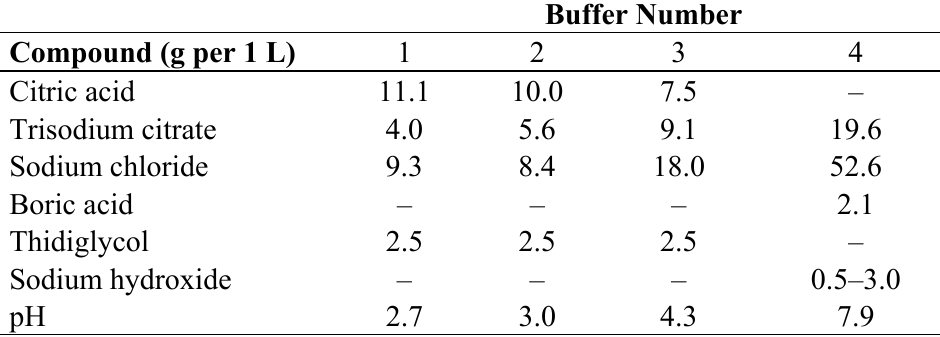
Table 4. Buffers for chromatographic determination of amino acids.